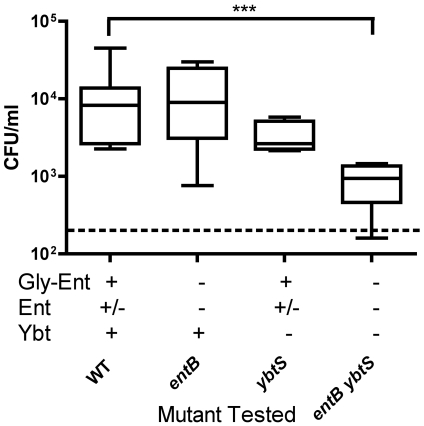

K. pneumoniae requires enterobactin or yersiniabactin, but not both, to colonize the nasopharynx efficiently.Colonization density was determined in C57BL/6 mice (n = 5 per group) at day 3 after intranasal inoculation with 2×106 cfu of the K. pneumoniae mutants indicated. Box and whiskers graph shows the median and interquartile ranges; the dashed line is the lower limit of detection (20 cfu/ml). Siderophores encoded by each mutant are indicated by a plus (+). *** p<0.001 by Mann-Whitney test.